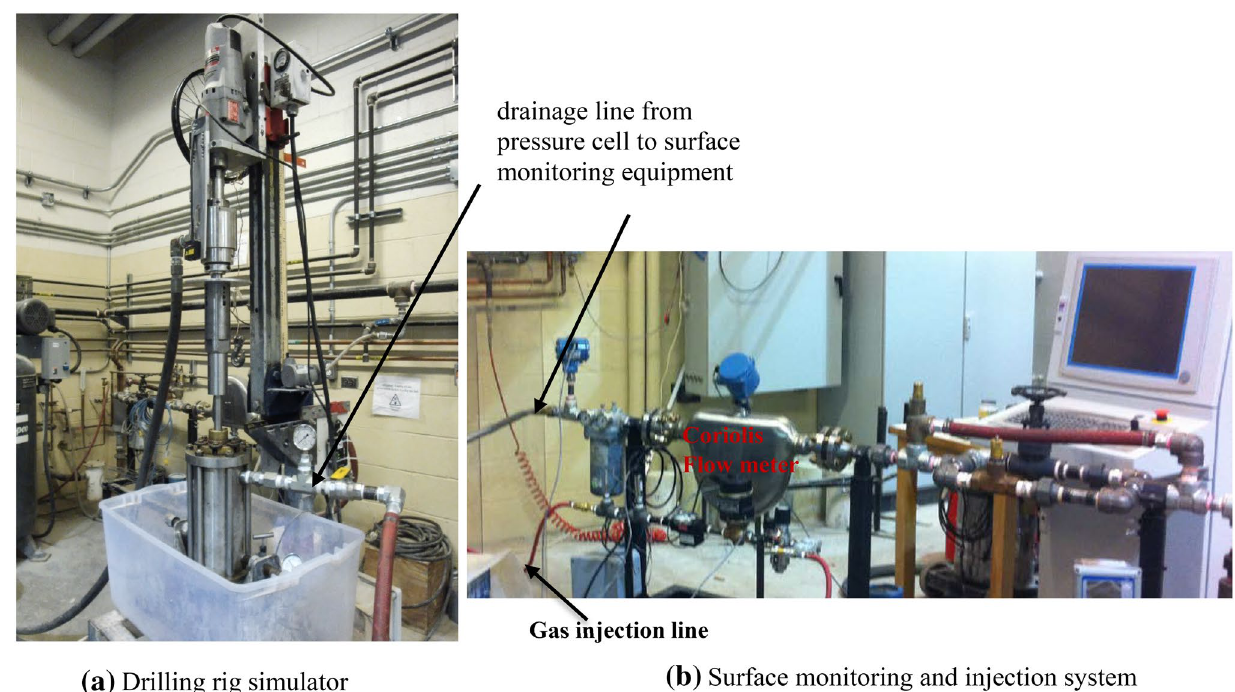
Fig. 1 Equipment setup for gas kick simulation experiment